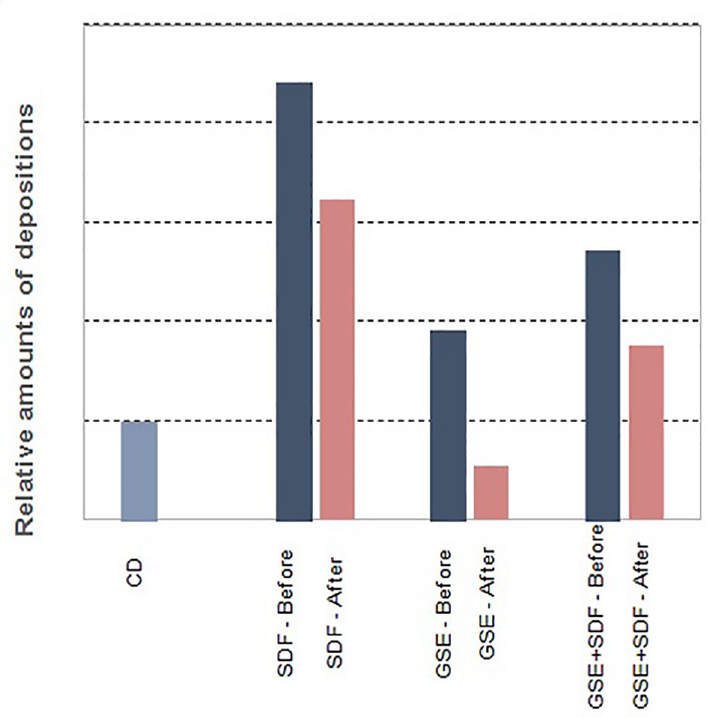
Fig 7. Histogram of depositions in the carious dentin and experimental conditions before and after acid challenge.